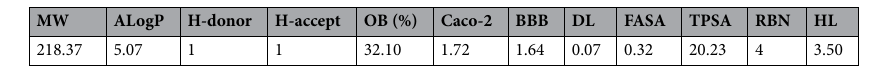
Table 1. Pharmacological and molecular properties of